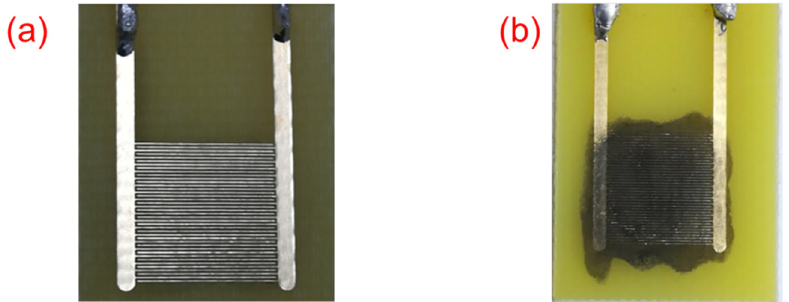
Figure 1. ( a ) gold-plated interdigitated electrode and ( b ) a prepared sensor.